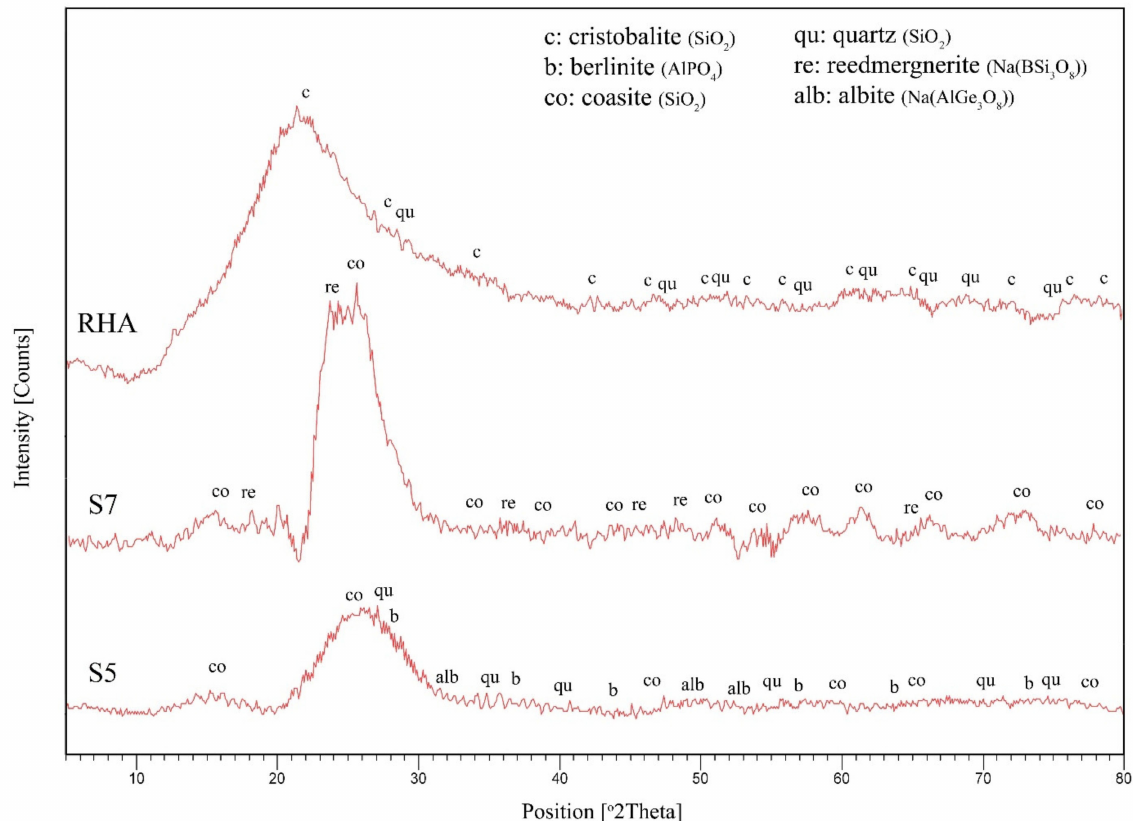
Figure 13. X-ray powder diffraction patterns of RHA, sample S7 and sample S5 before fire-retardant test. Delair et al. [52] found that this shift indicated changes in the local bonding environ- ment during the geopolymerization process. The shift also indicated large-scale alteration and reconstruction of silica–alumina order in the paste, as strongly demonstrated in the geopolymerization, which occurred due to the amorphous nature of the samples. Temuujin et al. [3] determined that the width of the XRD halo in the geopolymer-type sample material suggests a mixture of unreacted RHA and the material. The halo width can be determined by measuring the full width at half the maximum (FWHM). The XRD halo of sample